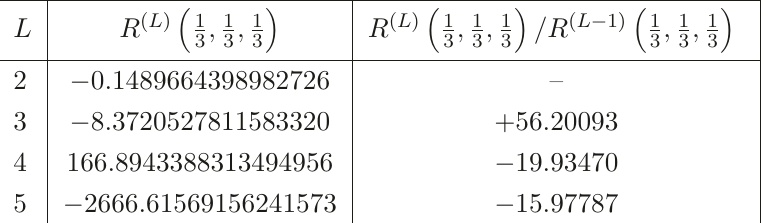
Table 6. The value of the L -loop remainder function at the symmetric point ( u, v, w ) = in the Euclidean region, as well as the ratio to the previous loop